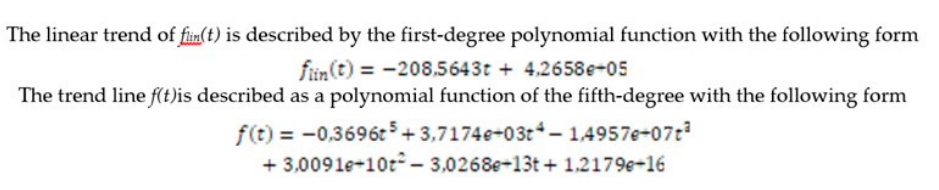
Figure 4. Trends of changes in the number of civil engineering workers slightly affected by workplace accidents over time.